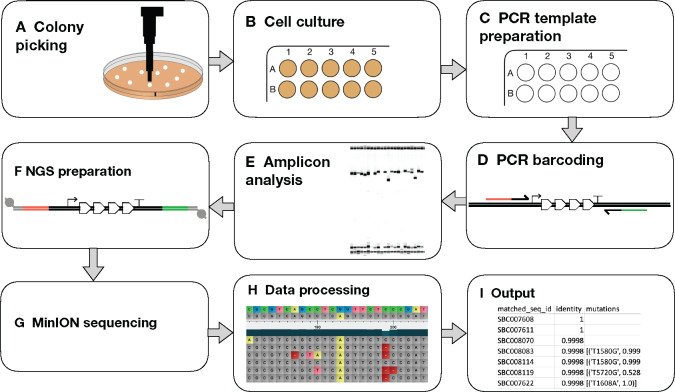
Overview of the construct-sequencing workflow. Colonies harbouring assembled plasmids are first (A) picked and (B) cultured in deep well plates, prior to (C) dilution to create the PCR template. (D) PCR amplification of the construct generates 5′ (red) and 3′ (green) barcoded amplicons which are (E) analyzed by capillary electrophoresis. (F) Pooled amplicons are prepared for NGS sequencing by adapter ligation and (G) sequenced using the MinION device. (H) Bioinformatics processing of data identifies mutations and removes systematic errors by probabilistic analysis and (I) data metrics are outputted.